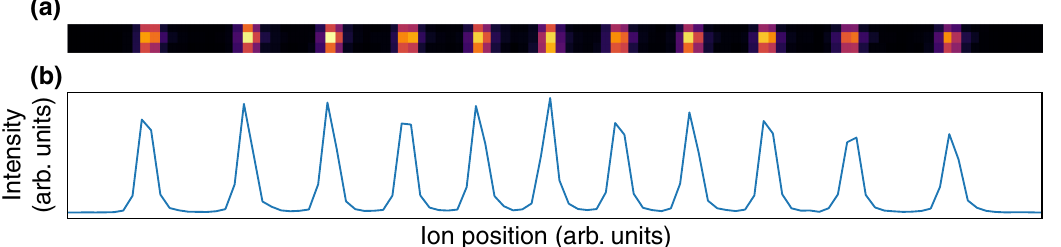
FIG. 11. Detection performance. (a) Fluorescence image of a linear string containing 11 ions. The axial trap frequency is ω ax = 2 π × 450 kHz, corresponding to a distance between the two center ions of 4 μ m. (b) Integration over pixel columns shows well-separated